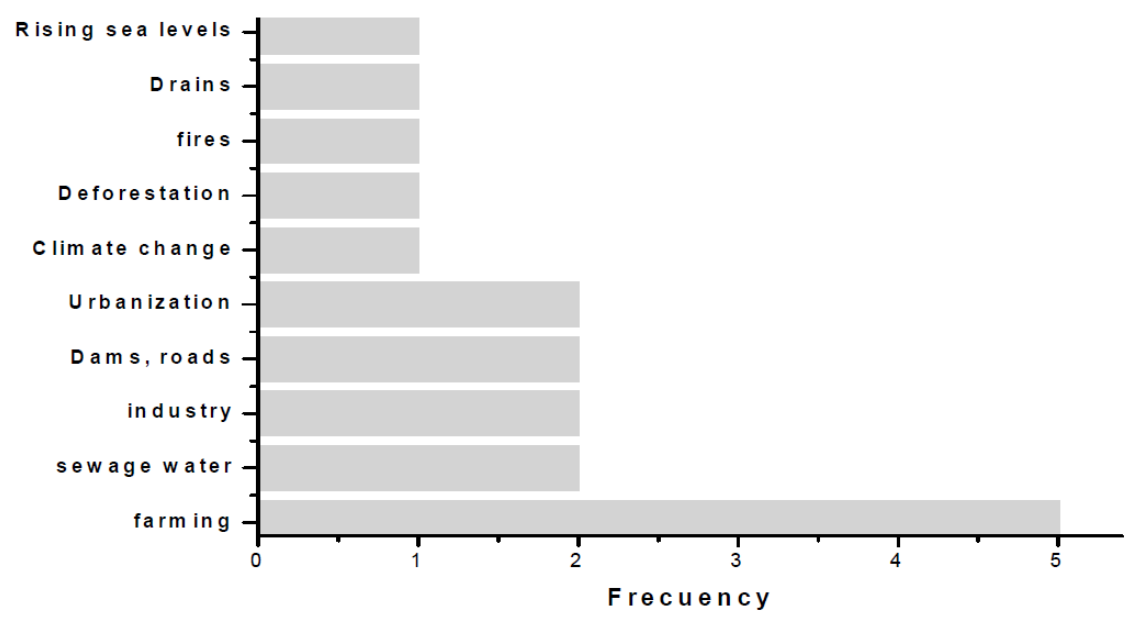
Figure 11. Frequency Distribution of Incident Factors in Oceania/Australia.